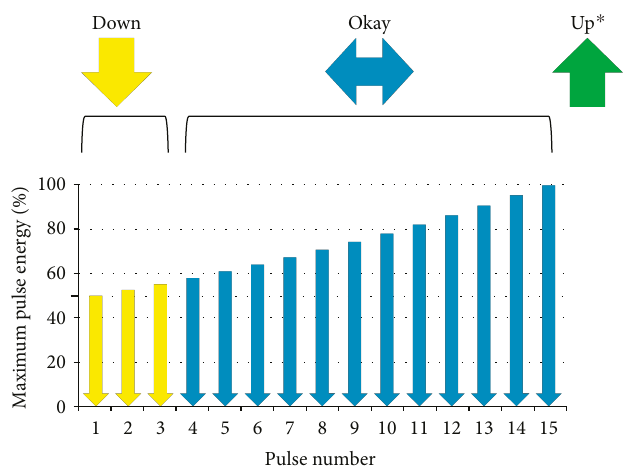
Figure 1: The laser pulse energy was emitted in a stepwise fashion (an increment of 3.57% for the following micropulse) for every individual spot. When there is an adequate feedback signal from the target retinal pigment epithelial (RPE) cells, the device stops the laser automatically during the 15-pulse set of a shot. If a shot was stopped at or between pulse numbers 4 and 15, the energy level would be deemed adequate for the shot and also adequate for the next shot. If the shot was stopped at earlier pulses, between pulse numbers 1 and 3, the shot ’ s treatment was adequate for that spot by having received desired feedback from RPE, but for the next shot, the device recommends a decreased energy level to ensure the safety of the next shot. Conversely, if the desired feedback from a set of 15 pulses is not achieved, that is, no bubble is detected, then the energy level settings are too low. In this case, the device recommends incremental energy increases to achieve the desired feedback from RPE. ∗ Up only if the laser was not stopped in 15 pulses.